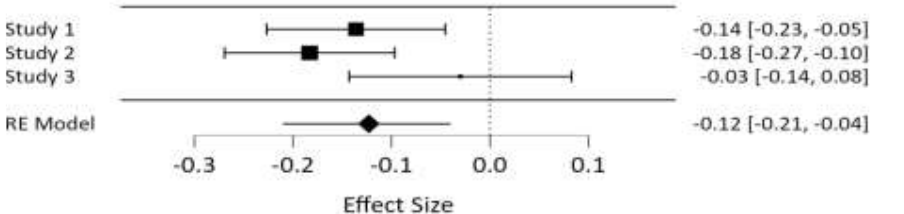
Figure 19. Forest plot of meta-analysis of Motivation for stimulation and Emotional